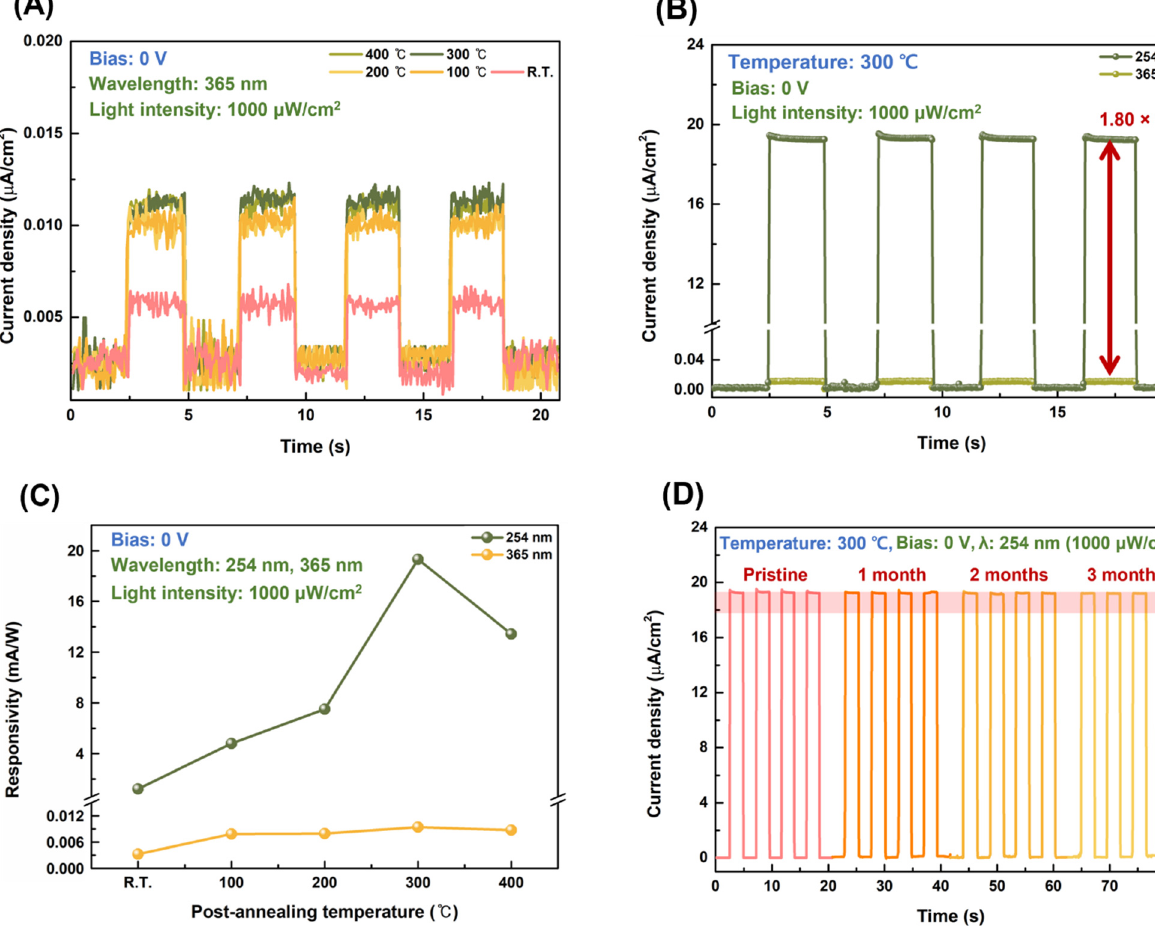
Figure 8. ( A ) Time-dependent photocurrent density characteristics of CuO/ β -Ga 2 O 3 heterojunction photodetectors with different postannealing temperatures at zero bias under 365 nm UV light with 1000 μ W/cm 2 light intensity; ( B ) rejection ratio of 254 nm to 365 nm light for photodetector postan- nealed at 300 °C; ( C ) variation of responsivity of photodetector postannealed at 300 °C with 254 nm and 365 nm light with 1000 μ W/cm 2 light intensity; ( D ) photostability test for photodetector stored